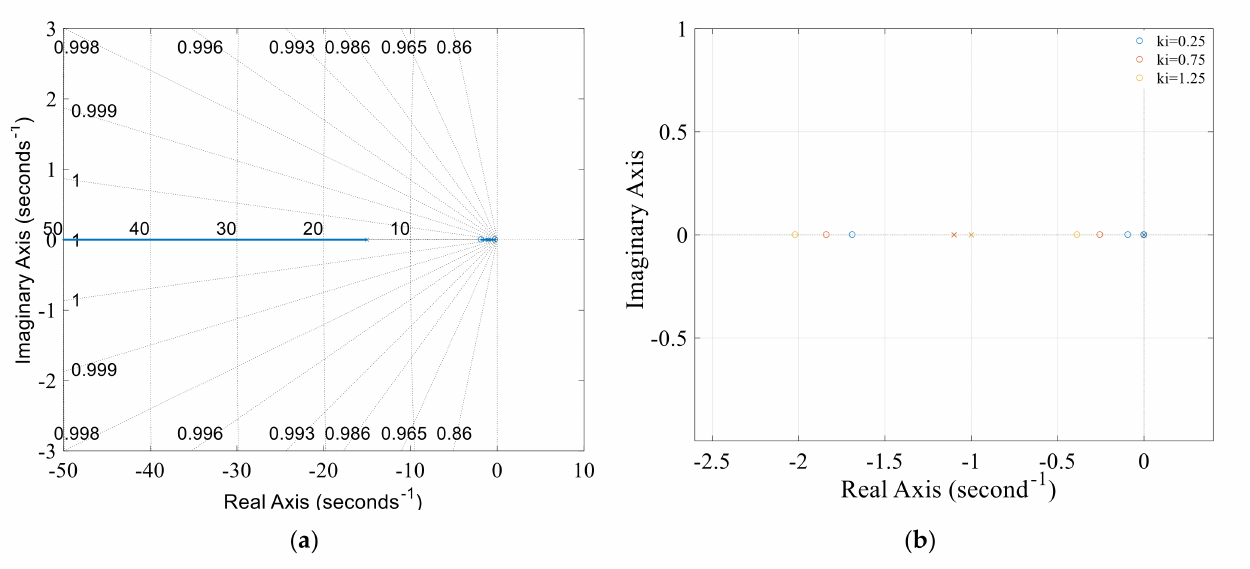
Figure 17. Root-locus response to the variation of the integral adjustment coefficient, k i = [0.25, 1.25]. ( a ) Root-locus response at k p = 1.6, k i = 0.75 and k d = 1, and ( b ) root-locus response with the variation of k i = 0.25, 0.75 and